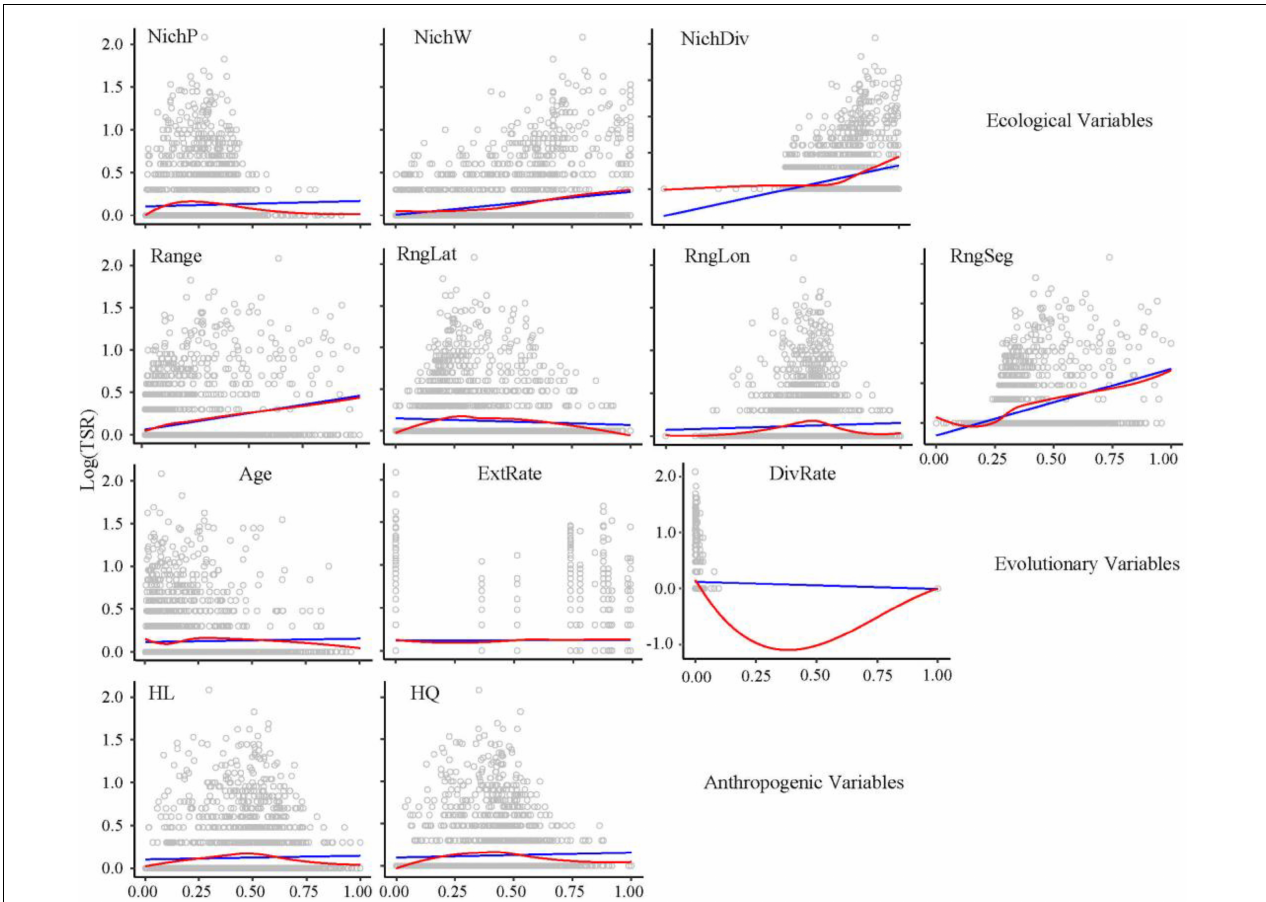
FIGURE 3 | Bivariate relationships of ecological, evolutionary, and anthropogenic predictors to TSR (log-transformed). Ordinary least squares linear regression (blue line) and locally weighted regression (red line) were fitted for all the maps. NichP, nich position; NichW, nich width; NichDiv, genus niche divergence; RngLat, range position (latitude); RngLon, range position (longitude); RngSeg, range segregation; ExtRate, relative extinction rate; DivRate, net diversification rate; HL, habitat loss; HQ, habitat